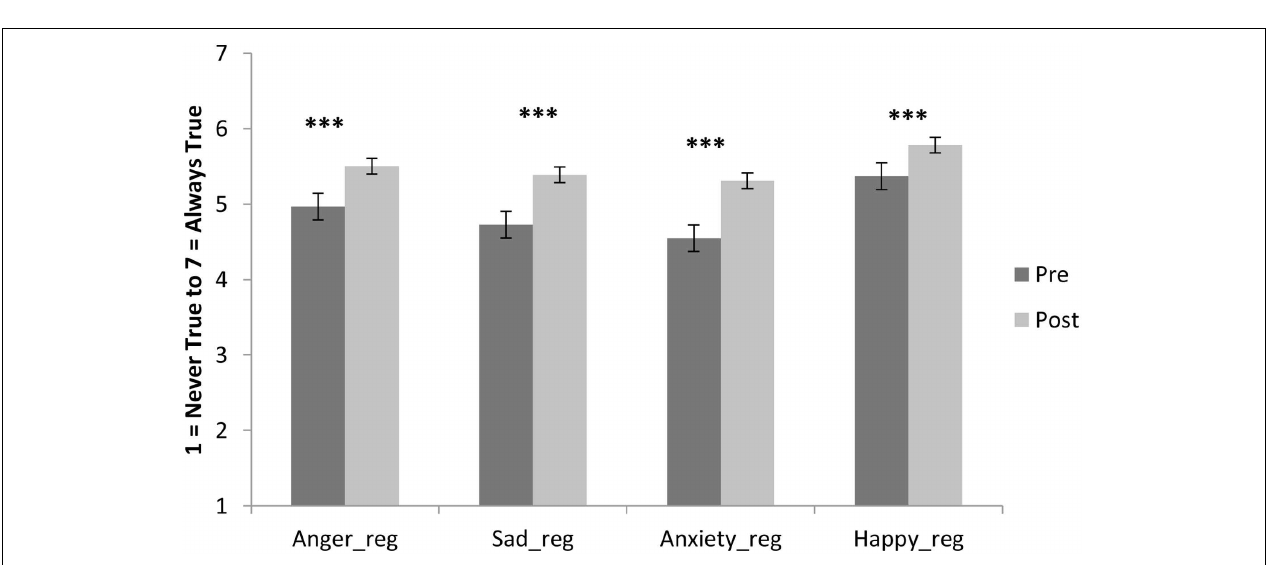
FIGURE 3 | Sample means for 216 mainstream adolescents on emotion variables at pre- and post-program. (Bars are standard errors; significance ∗∗∗ p < 0.001).